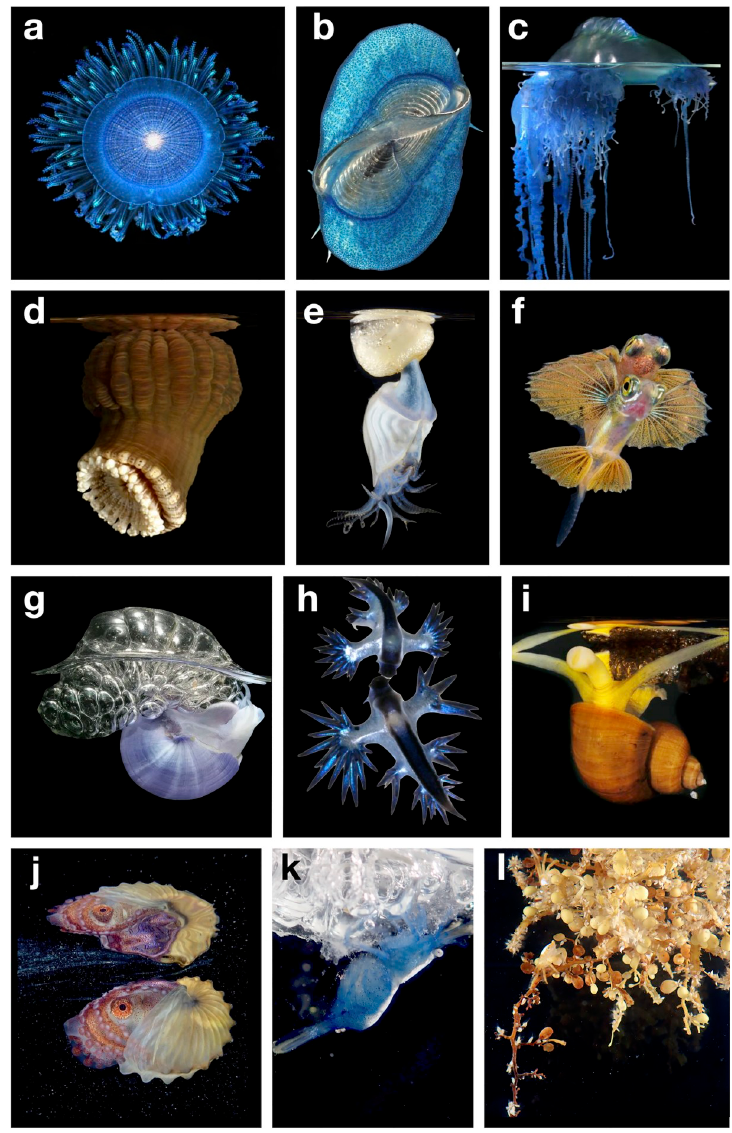
Fig 1. Diverse members of the ocean surface ecosystem. (a) Blue button Porpita sp. viewed from above, (b) by-the- wind sailor Velella sp. viewed from above, (c) Portuguese man-o-war Physalia sp. viewed from the side, with the float above the surface, (d) the floating anemone Actinecta sp. viewed from the side, with the aboral float at the surface, (e) buoy barnacle Dosima fascicularis viewed from the side, with aboral white float at the water’s surface, (f) a young flying fish (family Exocoetidae) viewed from below, reflected in the surface above, (g) violet snail Janthina sp. viewed from the side, with a large bubble raft made from snail mucus emerging from the water, (h) blue sea dragons Glaucus sp. viewed from above with dark blue ventral surfaces, (i) the snail Recluzia sp. viewed from the side oral end, (j) paper nautilus Aurgonaut sp. viewed from the side and reflecting off the water’s surface, (k) a shrimp in the family Hippolytidae, clinging to a discarded Janthina bubble raft, (l) seaweed Sargassum sp. with a small sargassum crab Portunus sayi . Images a–e and g–i by Denis Riek, f and j by Songda Cai, k and l by Rebecca R. Helm. ( Oncorhynchus ), and billfish (Istiophoriformes). Neuston can be concentrated as living islands that completely obscure the sea surface (Fig 2), or scattered into sparse meadows over thou- sands of miles. Yet the role of the neuston, and in many cases their mere existence, is often overlooked.